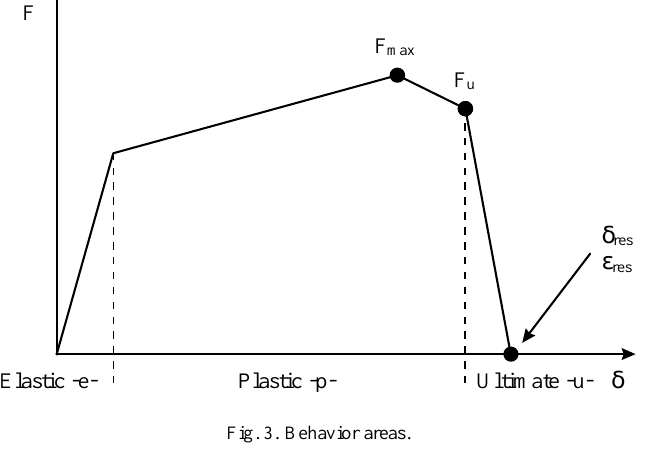
Fig. 3. Behavior areas.